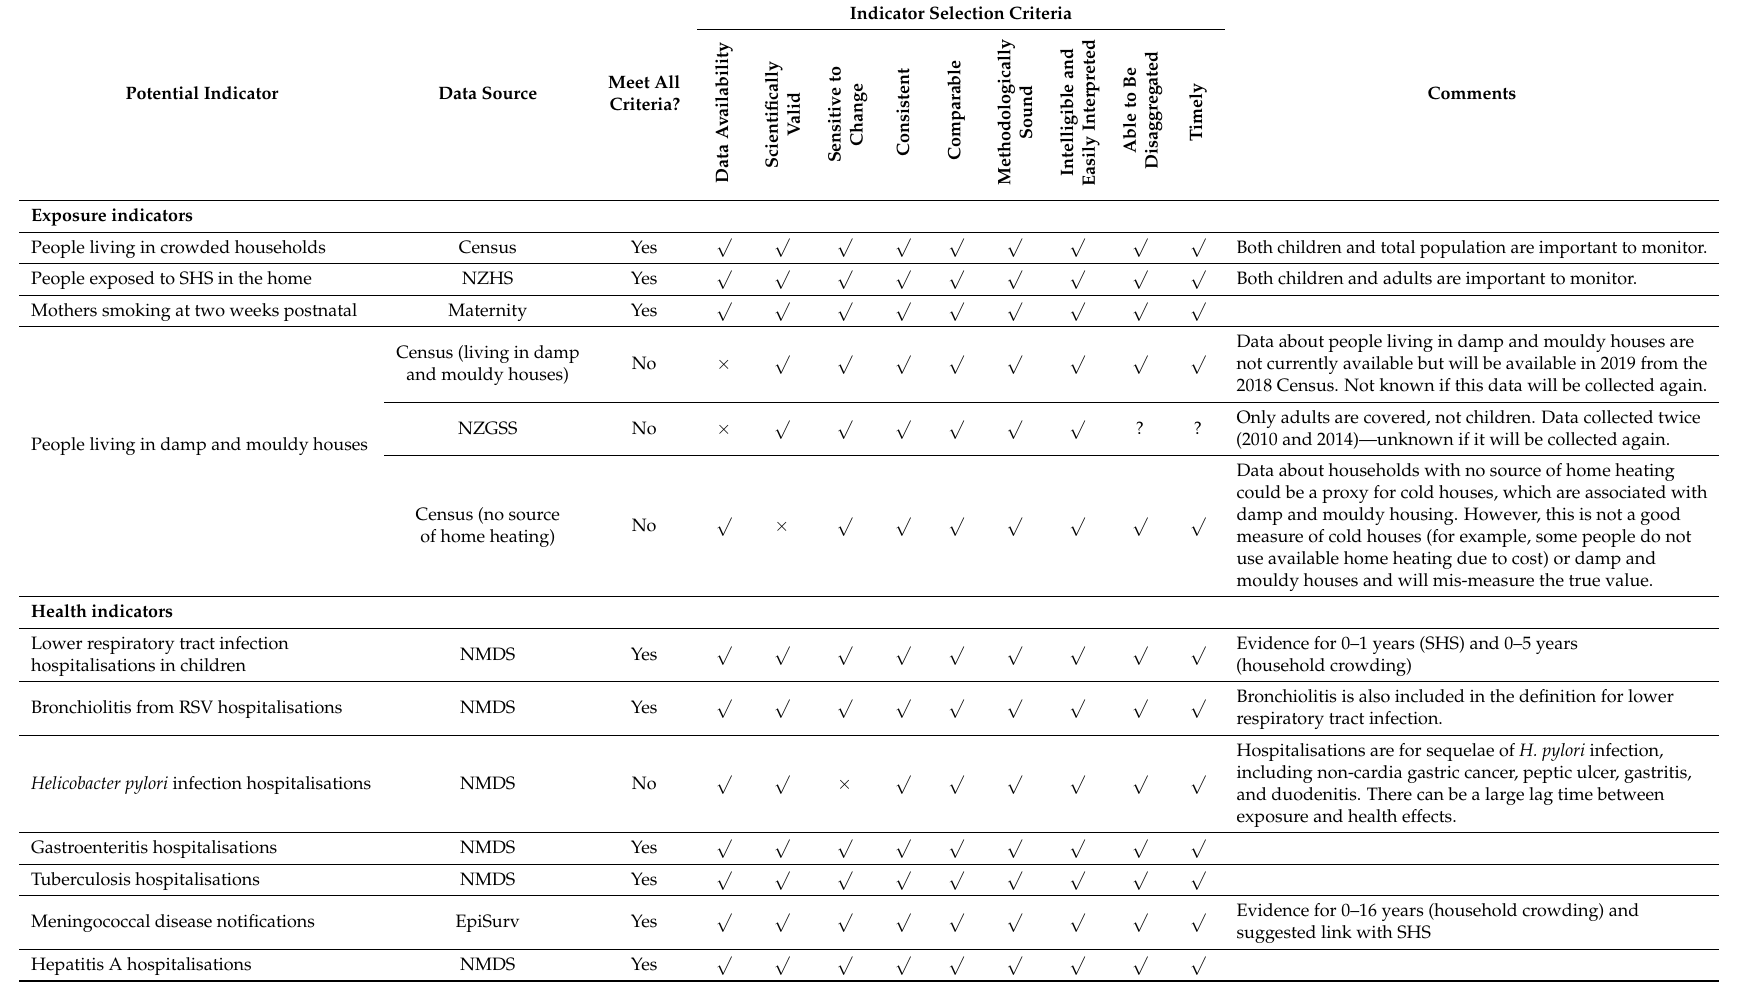
Table 4. Potential environmental health indicators identified for the indoor environment ( n =